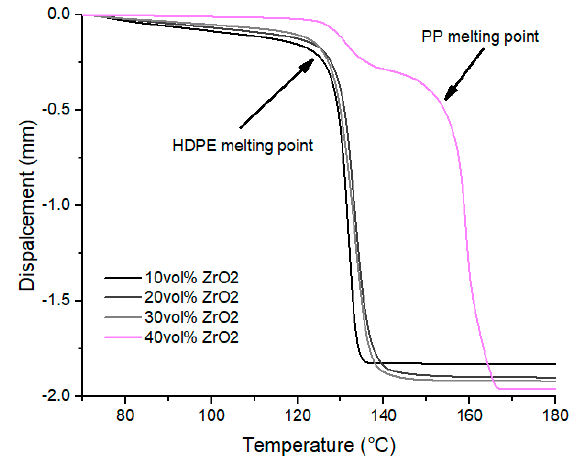
Figure 12. Penetration tests on blends HDPE / PP / wax (70 / 30) for di ff erent Zirconia particle contents.